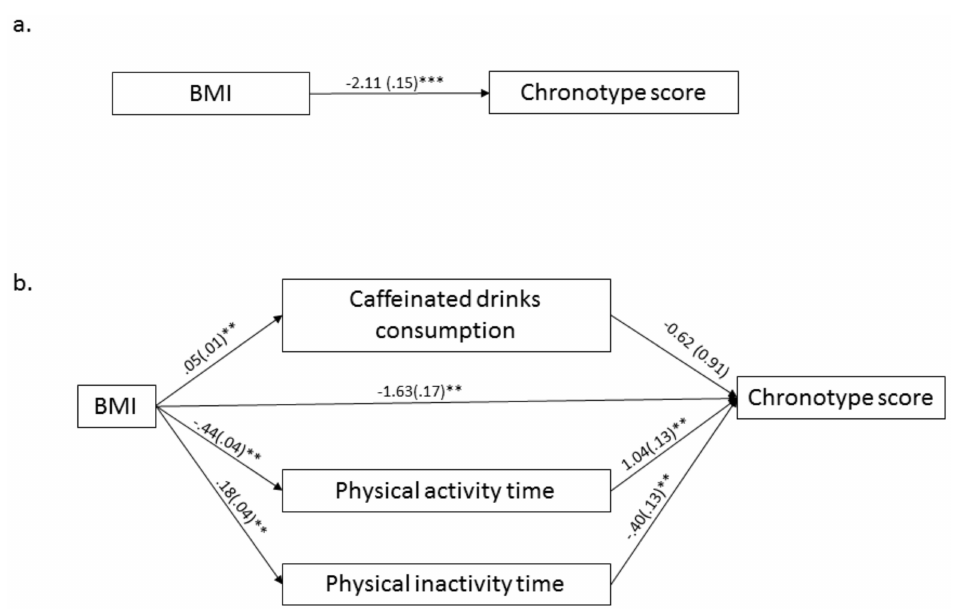
Figure 2. Reversed multiple mediation model between BMI values and chronotype scores.